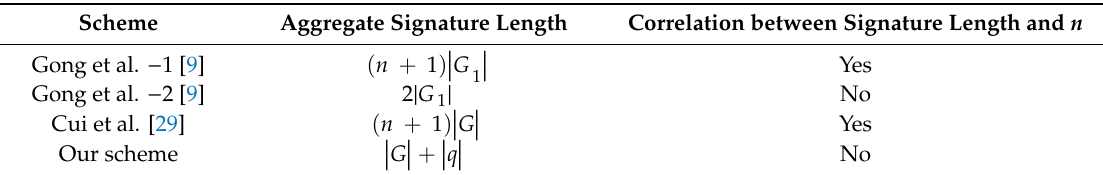
Table 6. The comparison of communication cost.